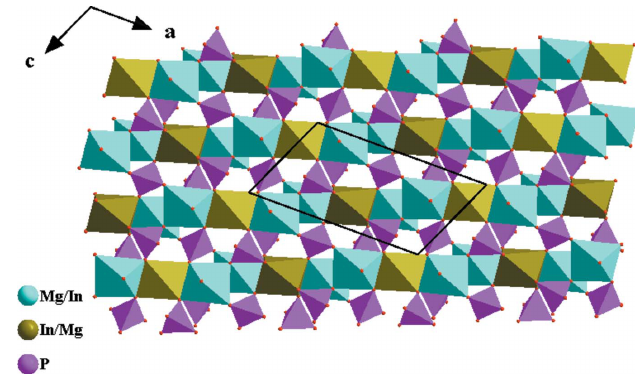
Figure 4 [(Mg/In)O 6 ] octahedra and PO 4 tetrahedra forming a sheet extending parallel to (010). Data taken from